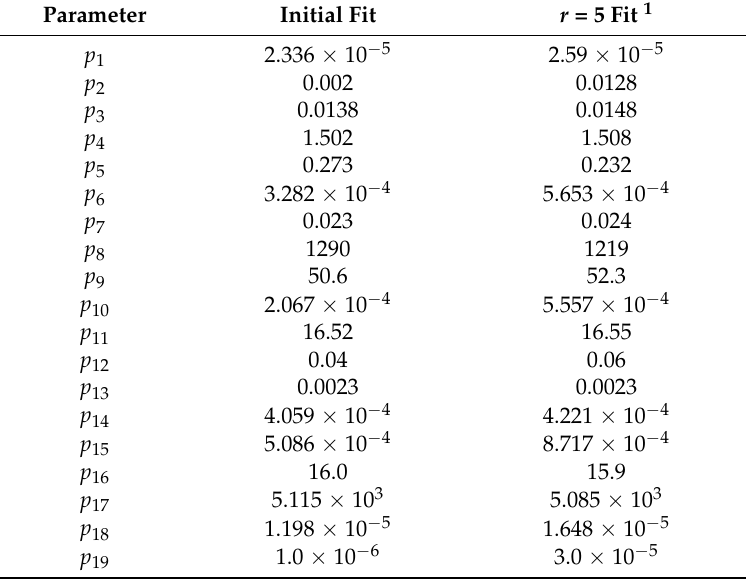
Table A1. Parameter values from initial parameter fit [2] and from optimal r = 5 input